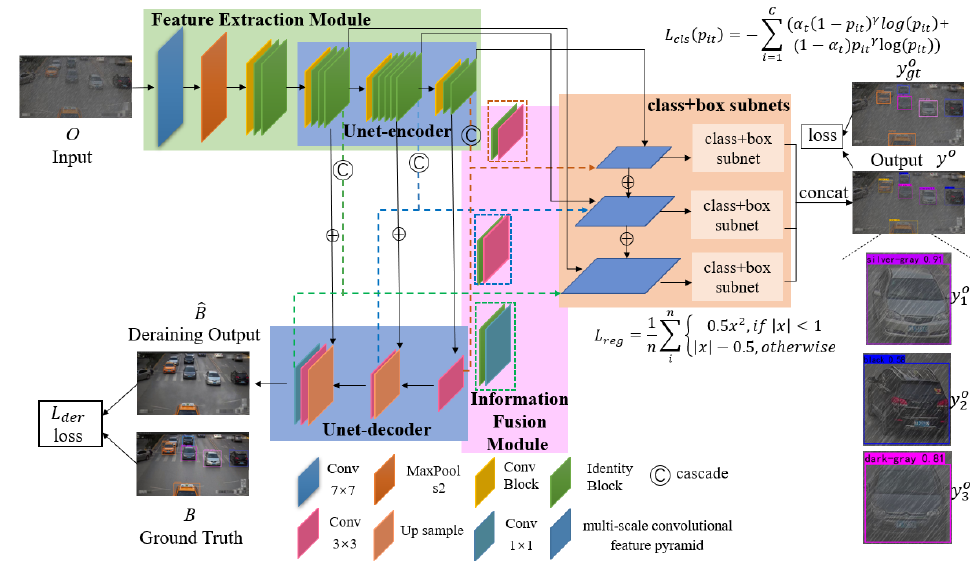
Figure 1. Framework overview for our JADAR ; detailed explanations are in the